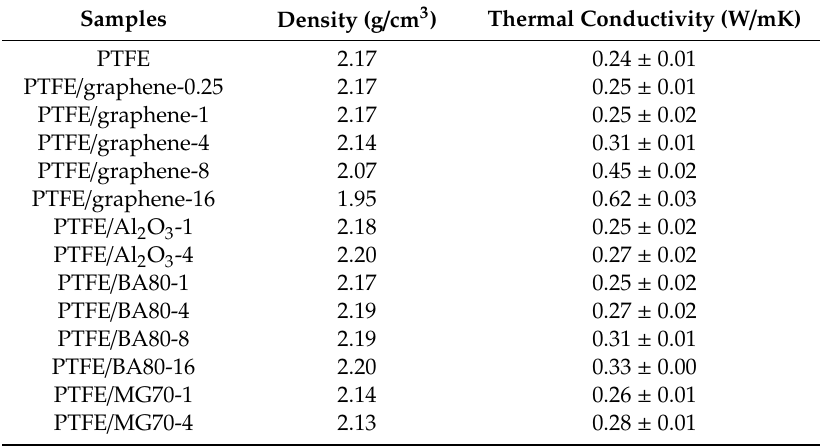
Table 2. Average density and thermal conductivity of sintered PTFE materials. The standard deviation of the density was less than ± 0.003 (g / cm 3 ) for all of the